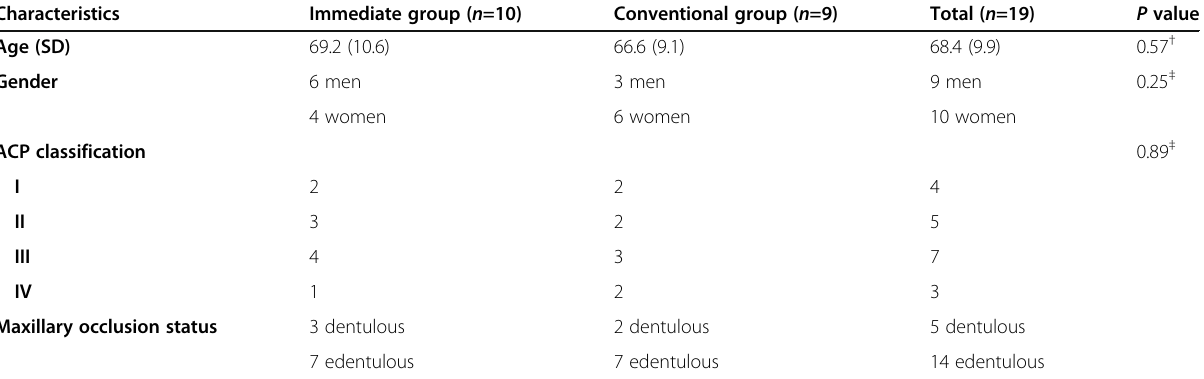
Table 1 Baseline characteristics of participants Characteristics